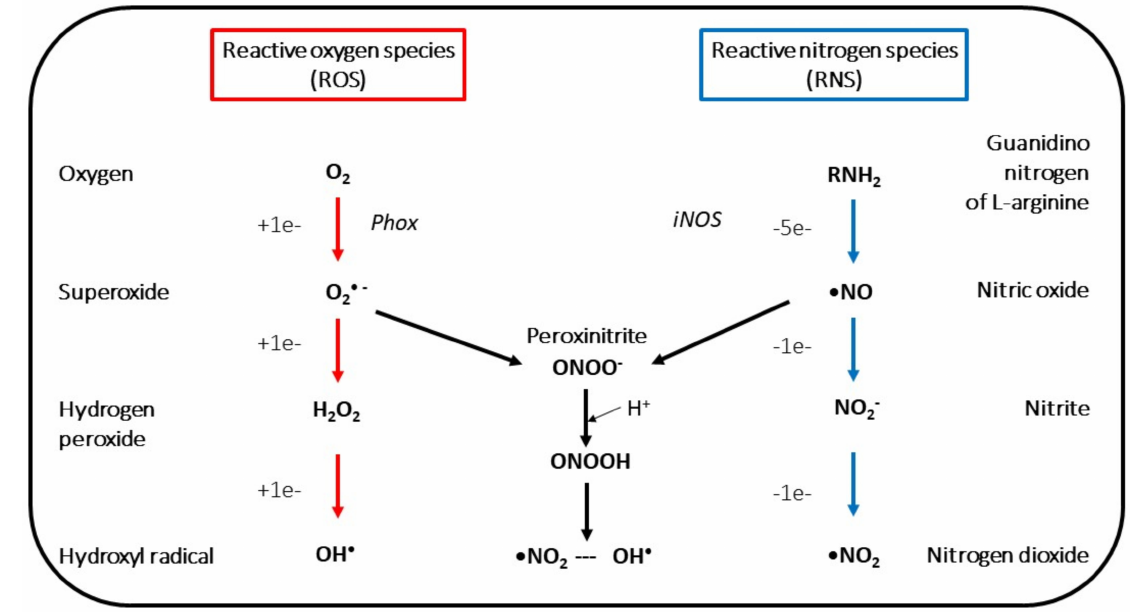
Figure 1. Reactive oxygen and nitrogen species production in mammalian